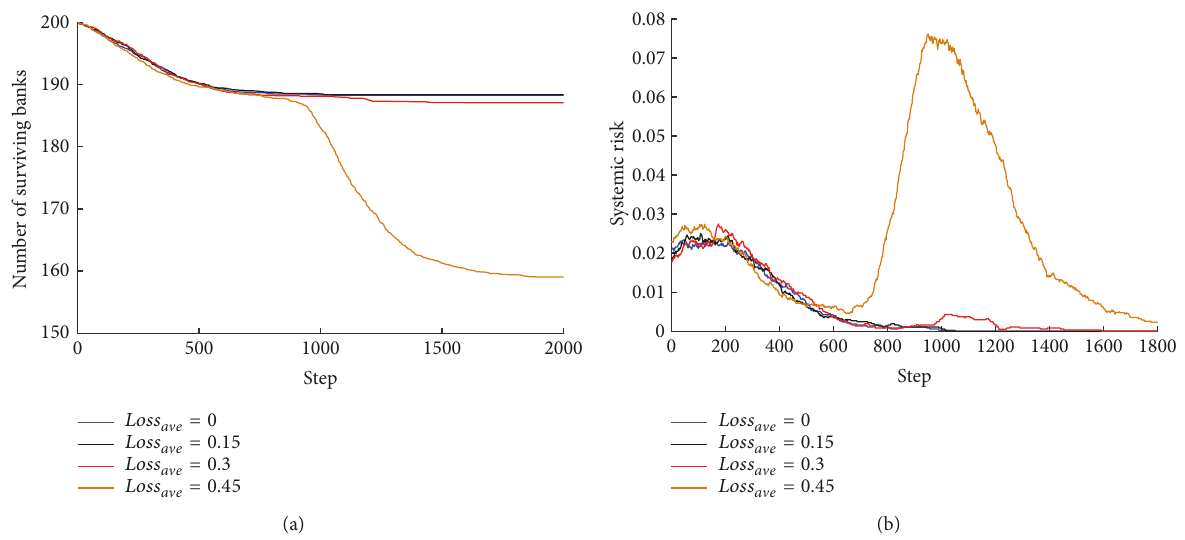
Figure 10: (a) The evolution process when the investment suffer a loss at step 750. (b) Systemic risk when the investment suffers a loss at step 750. The parameters are set as 𝑑 = 0.0533 , 𝛿 𝑎 V 𝑒 = 0.009 , 𝜃 = 0.04 , 𝑝 = 0.05 , 𝜎 𝐴 = 0.15 , 𝜎 𝑤 = 0.25 , 𝐶 = 0.03 𝐴 = 1000 , 𝑤 = 500 , 𝜒 = 0.3 , 𝛽 = 0.25 , 𝐵𝑎𝑛𝑘𝑁𝑜 = 200 , 𝐴𝑠𝑠𝑒𝑡𝑁𝑜 = 150 , 𝑟 = 0.004 , and 𝑟 = 0.008 . 𝑎 𝑎